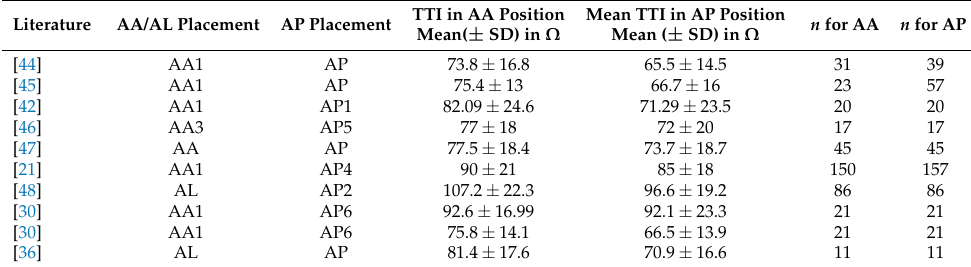
Table 3. Different AA vs. AP TTI measurements: A comparison of the literature. The symbol AP without specification was denoted when no further information on AP position was